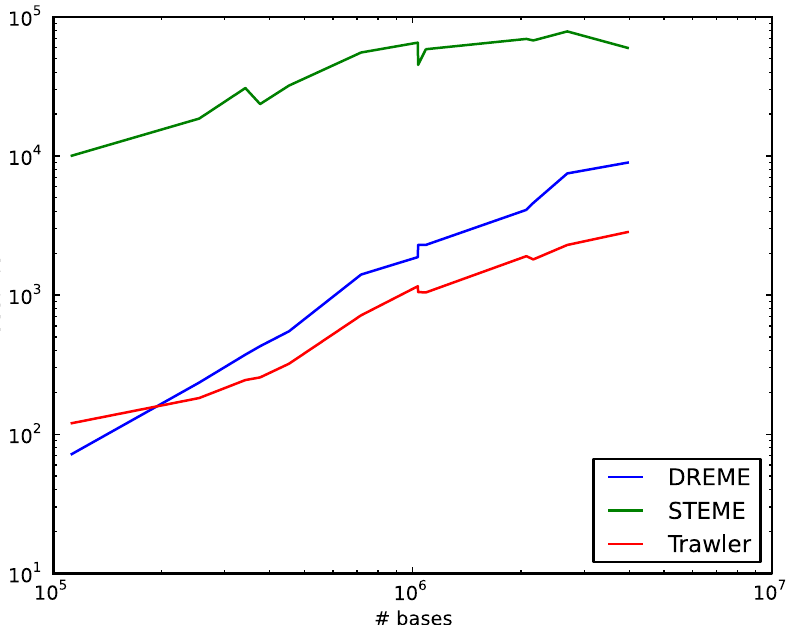
Figure 3. Log-log plot of timings for the three evaluated algorithms. STEME is slower than DREME and Trawler but this difference is less pronounced on larger data sets.